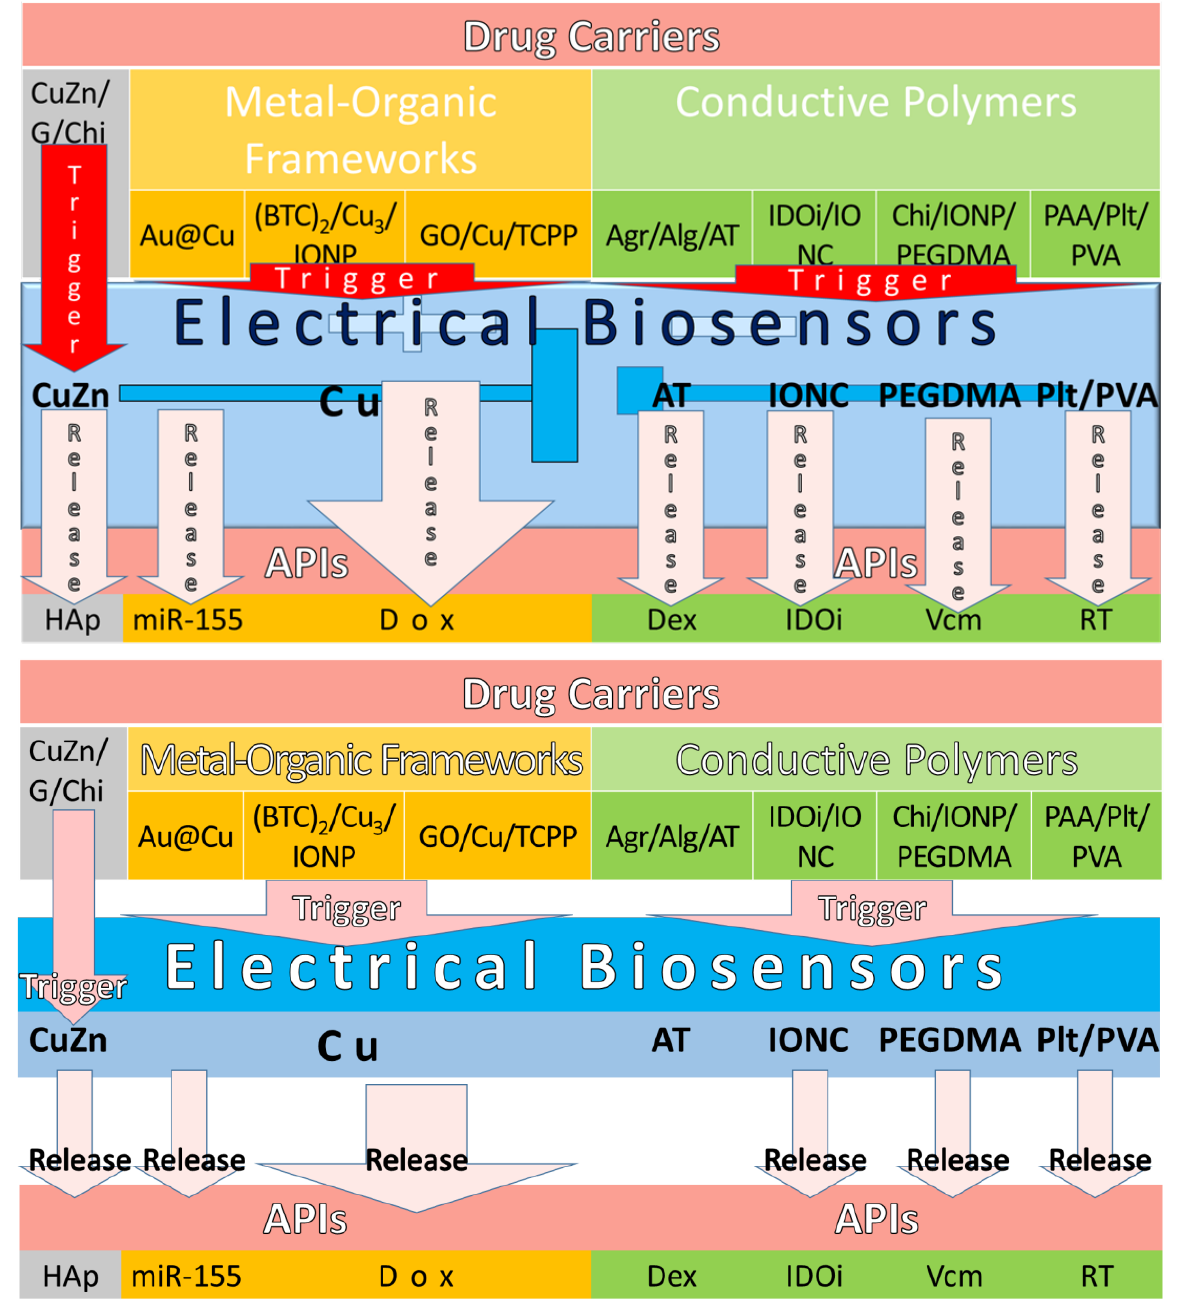
Figure 6. The electrical biosensors are triggered to release API in drug carriers that are made of MOFs and conductive polymers.